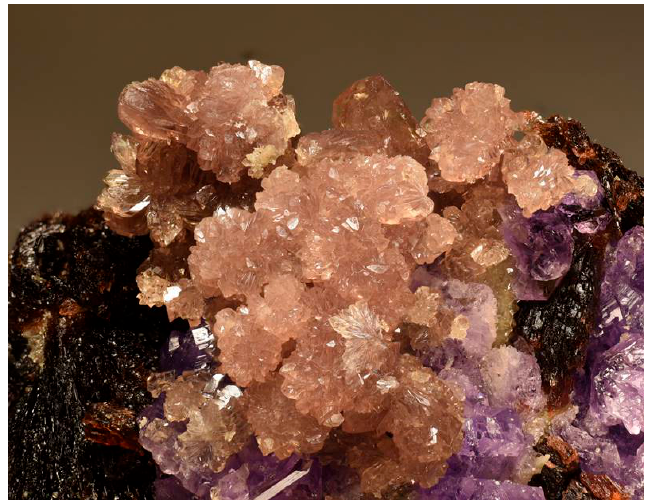
Figure 17. Krausite from the Monte Arsiccio mine, as aggregates of tabular crystals, up to 1 cm, with violet coquimbite and brown römerite.